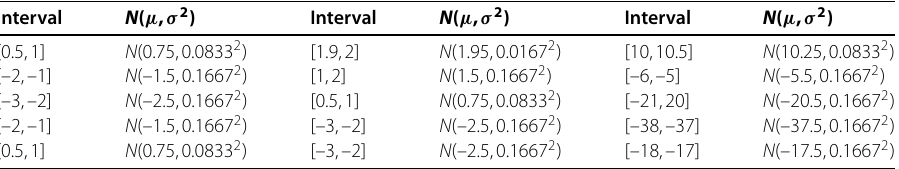
Table 3 Normal distributions corresponding to interval coefficients in all the constraints of Example